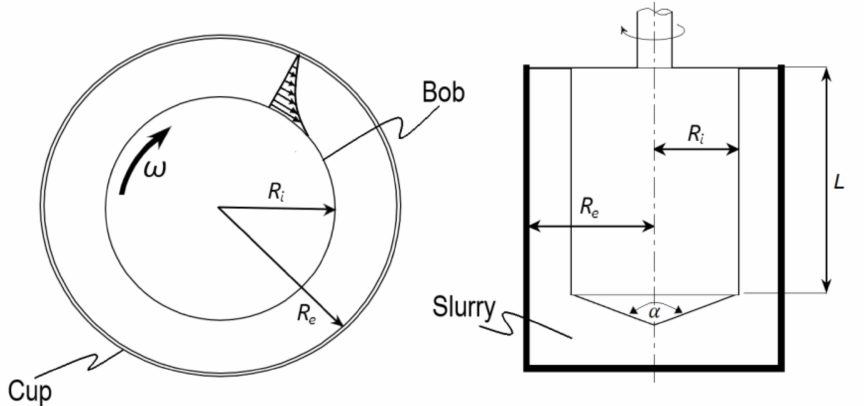
Figure 2. Searle principle: the instrument’s motor rotates the measuring bob inside an immovable cup filled with slurry ( α cyl.cone = 120 ◦ ).